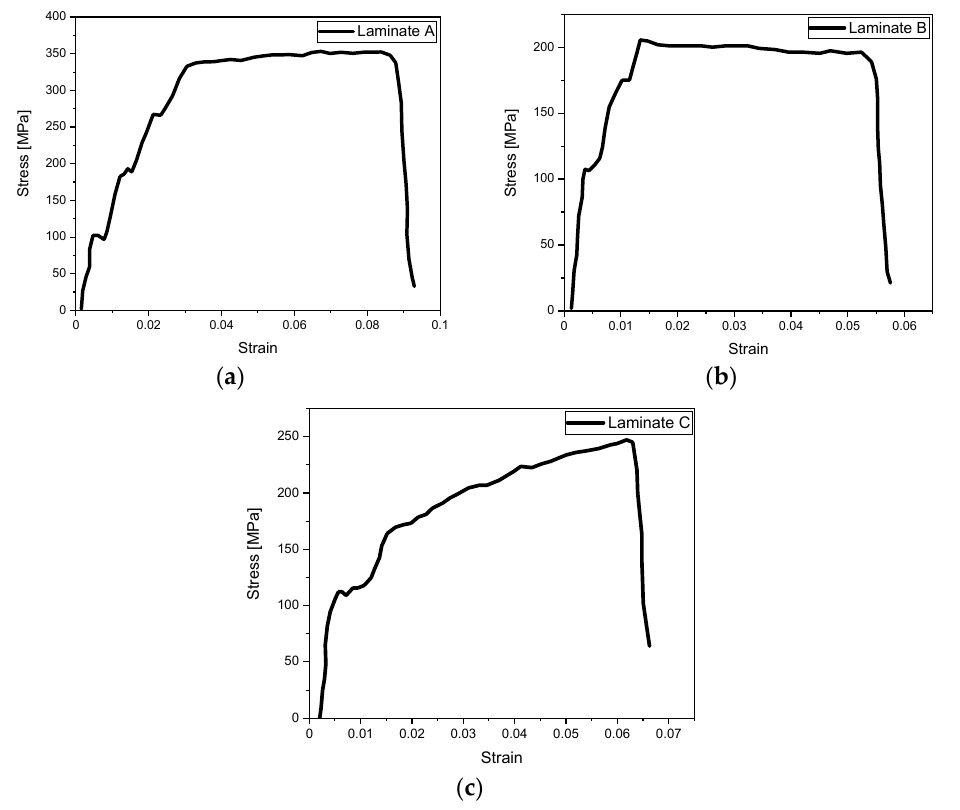
Figure 6. Stress–strain curves of ( a ) laminate A; ( b ) laminate B; ( c ) laminate C.